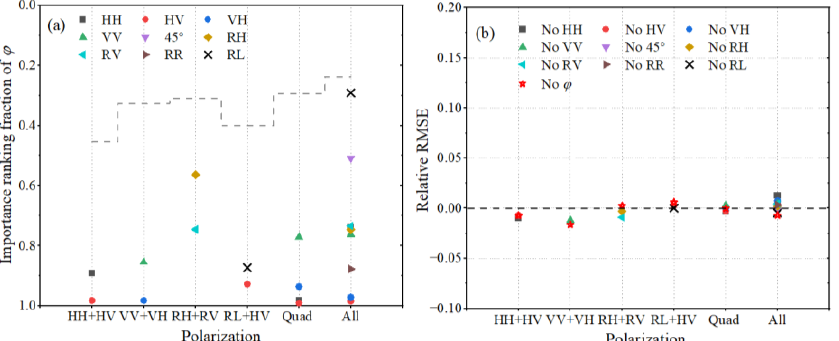
Figure 24. The importance of λ p to SWH retrieval from combined-polarization models. ( a ) The im- portance ranking of λ p provided by XGBoost models, normalized to the range of 0 – 1. ( b ) The effect of removing λ p on the SWH estimation from different polarized models. The red pentagrams represent the relative RMSE corresponding to the removal of λ p -terms in the combined-polarization models.